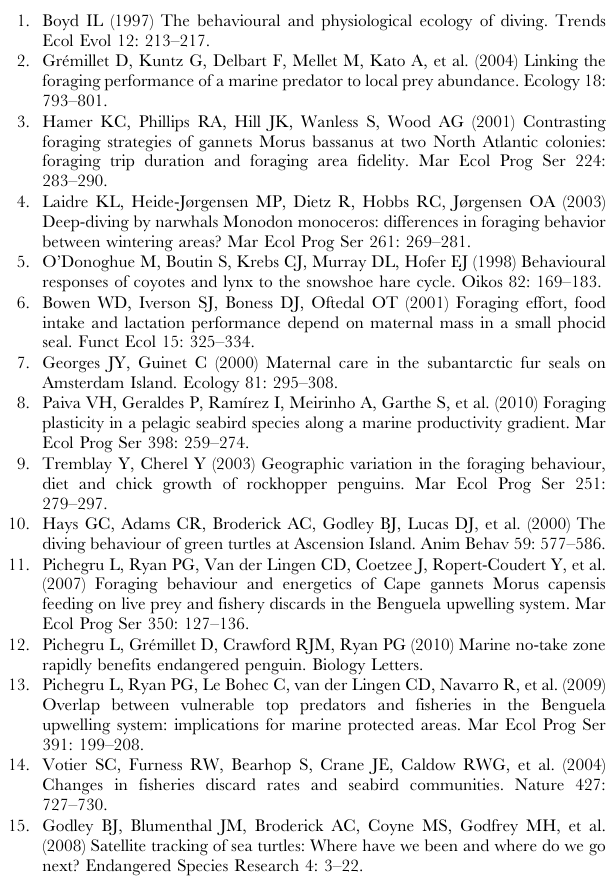
Table S1 Summary of diving behaviour, swimming/apparent/ current velocities and time spent in transit area/temporary residence area (TRA)/inter-TRA in oceanic (O) or neritic (N) domains in 16 Argos tracked leatherback turtles during their migration between 2005 and 2008 (see Fig. 1). Transit areas correspond to the time turtles spent from their nesting beach to their first TRA. TRAs correspond to 1 u * 1 u areas where turtles spent more than 90 hours. Inter- TRAs correspond to the time turtles spent between two TRAs (see M&M for details). * for PA05- 2, the 35 days at the end of the track were not taken into account due to the very few numbers of locations obtained during this period. Differences between areas were statistically tested using Kruskal-Wallis test followed by a post-hoc Bonferroni test. Different letters indicate significant (p , 0.05) differences among areas. Values are expressed as mean 6